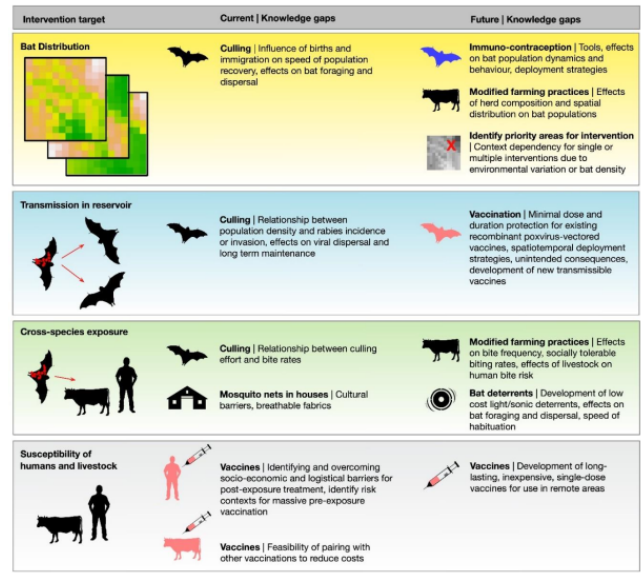
Figure 2. Filling research gaps to optimize current and future interventions against Desmodus rotundus rabies virus. All silhouettes were obtained from creazilla.com and are available on an open source license. Figures were made in R